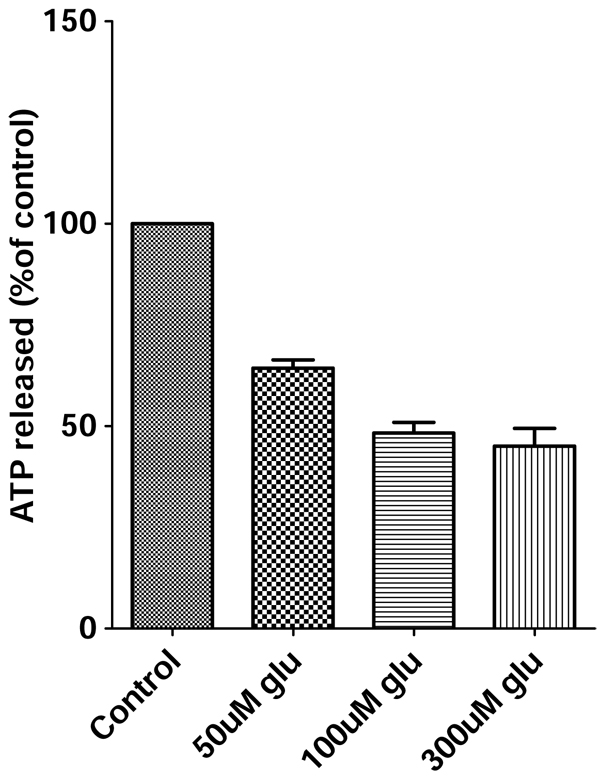
Effect of glutamate on cell viablility - A dose-dependent study. Primary cortical neurons were exposed to 50 uM, 100 uM and 300 uM glutamate for 4 hours and cell viability was measured by ATP assay.